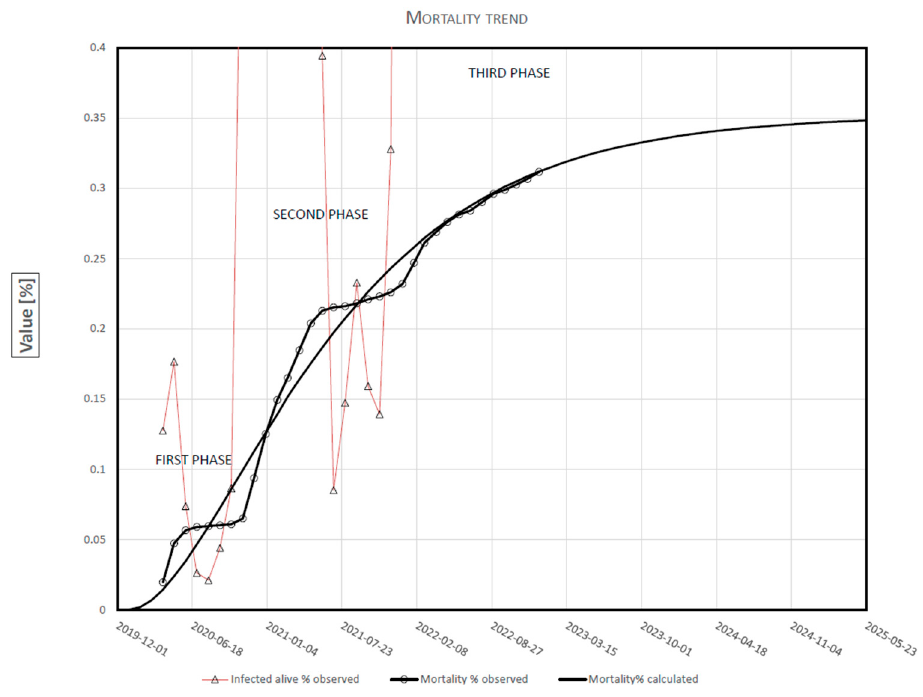
Figure 2. COVID-19 Mortality time-course in Italy.